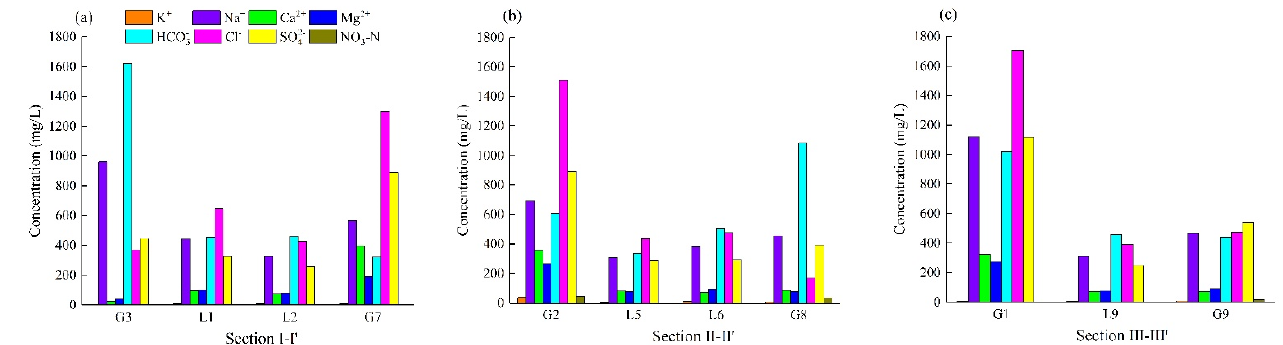
Figure 4. Linear distributions of hydrochemical indices along the three section lines ( a ) Section I–I ′ , ( b ) Section II–II ′ and ( c ) Section III–III ′ linking the groundwater (represented by points beginning with G) and lake water (represented by points named beginning with L). The direction from left to right in this figure represents west to east. The locations of the three lines are shown in Figure 3d.